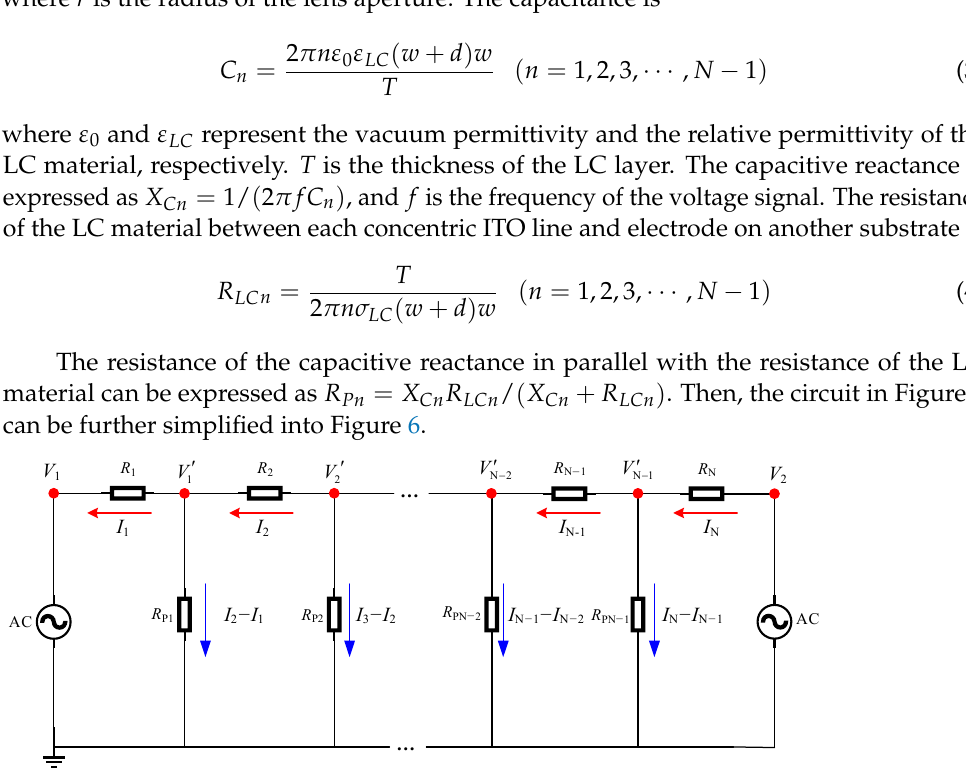
where σ e , w , d and t represent the conductivity, width, inter-line gap, and thickness of the  , w , d and t represent the conductivity, width, inter ‐ line gap, and thick ‐ where ITO electrode, respectively. N = (cid:98) r / ( d + w ) (cid:99) is the number of the concentric ITO line, e where r is the radius of the lens aperture. The capacitance is ness of the ITO electrode, respectively.